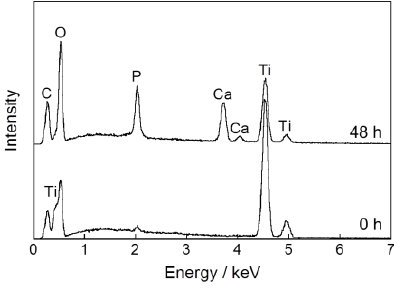
Figure 2. EDX spectra of the surfaces of Ti pins before (0 h) and after (48 h) immersion in the CaP solution at 25 °C for 48